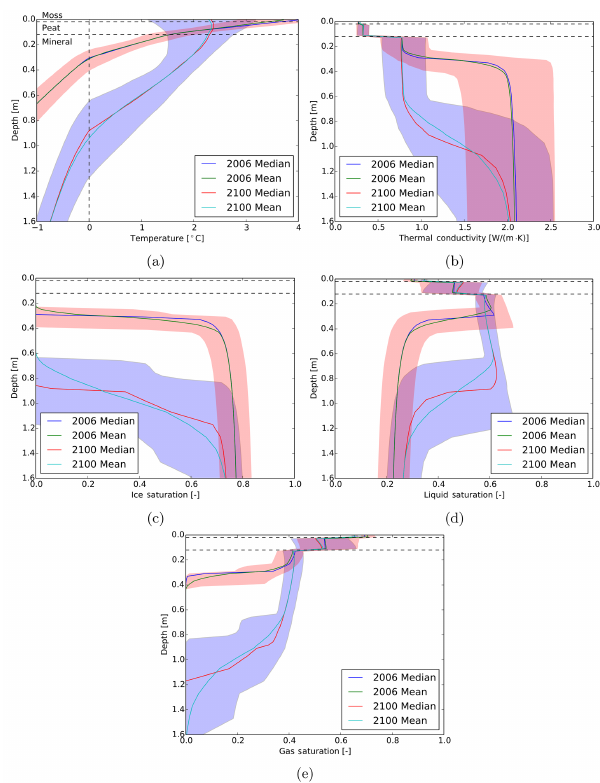
Figure 7. Predictive uncertainty due to soil property uncertainty for depth profiles of ensemble statistical quantities when ALT occurs for calendar years 2006 and 2100. The shaded regions are the 95% confidence intervals for 2006 (red) and 2100 (blue).